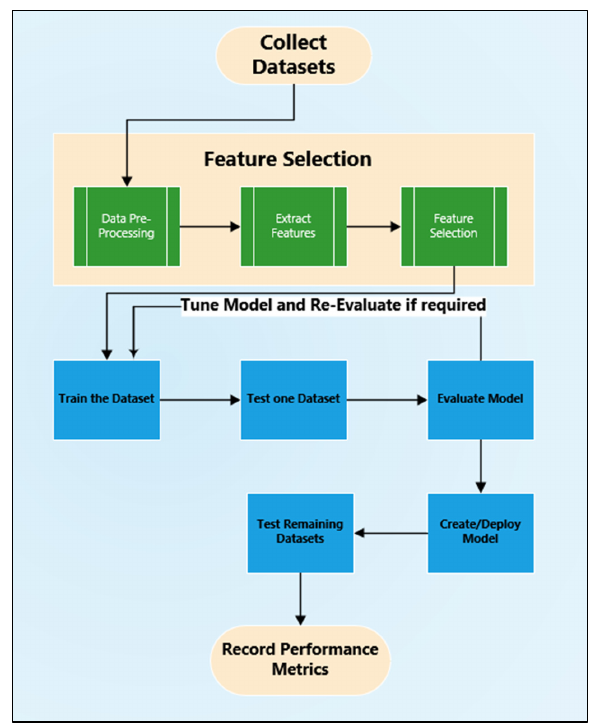
Figure 4. System